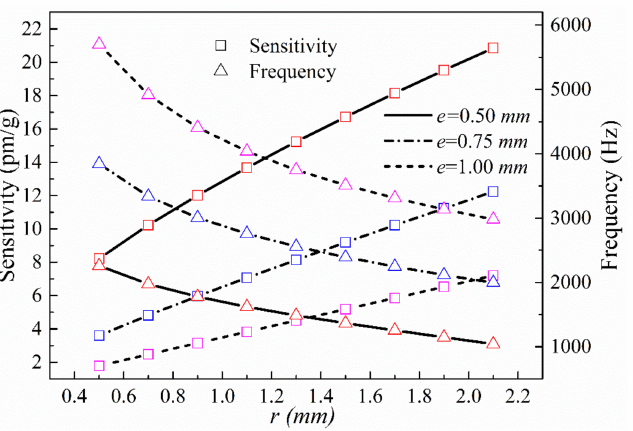
Figure 6. Sensitivities and natural frequencies in the z-direction as a function of r for different values of e